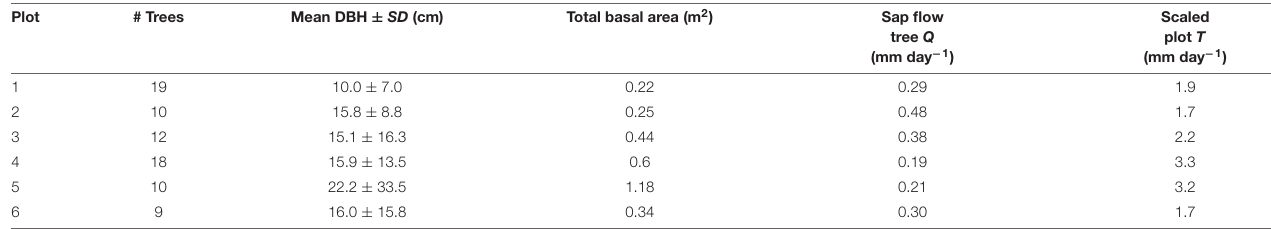
TABLE 3 | Scaled transpiration for the dominant tree in each plot (Sap flow Tree Q ; equation 3) and plot level transpiration for all trees within the 5 m radius plot (Plot T ; equation 4), reference ( Figure 2 ). Plot # Trees